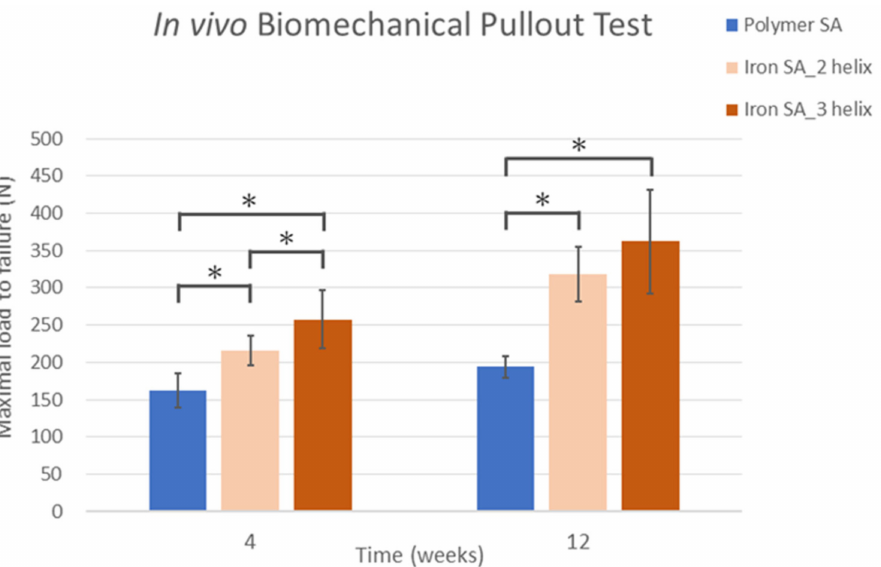
Figure 3. In vivo biomechanical ultimate pullout strength assessment for different suture anchors.